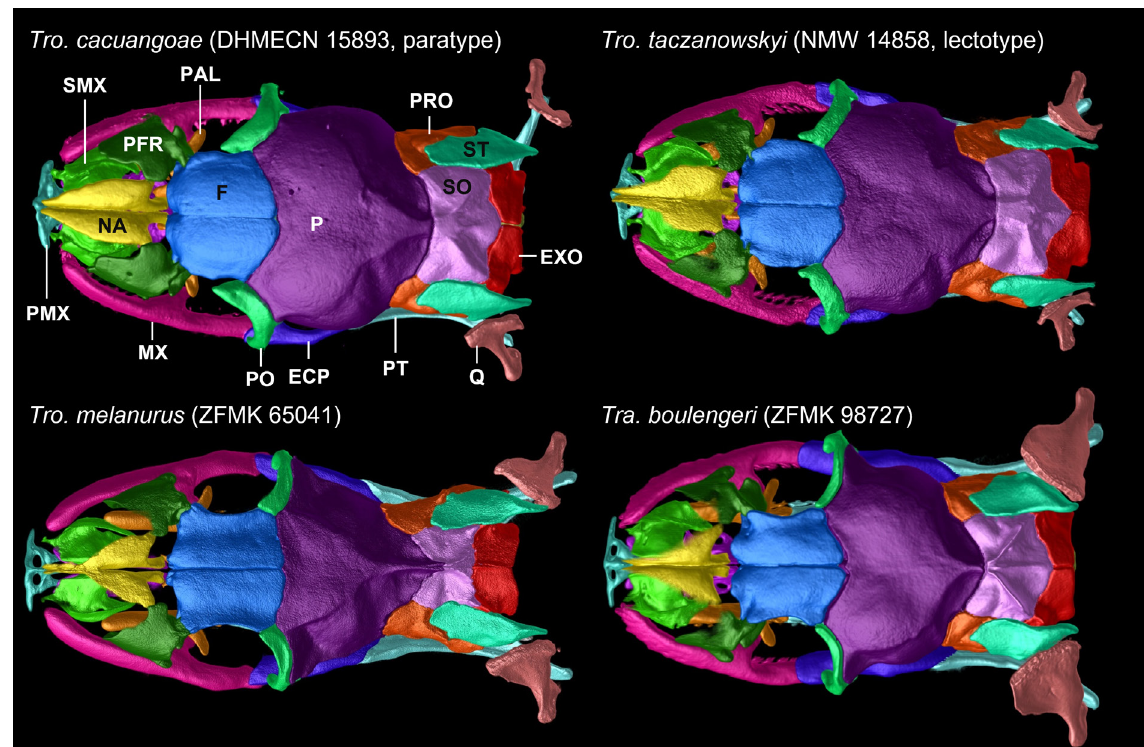
Fig. 9. Micro-CT images of the dorsal view of the skulls of Tropidophis cacuangoae sp. nov., ♀